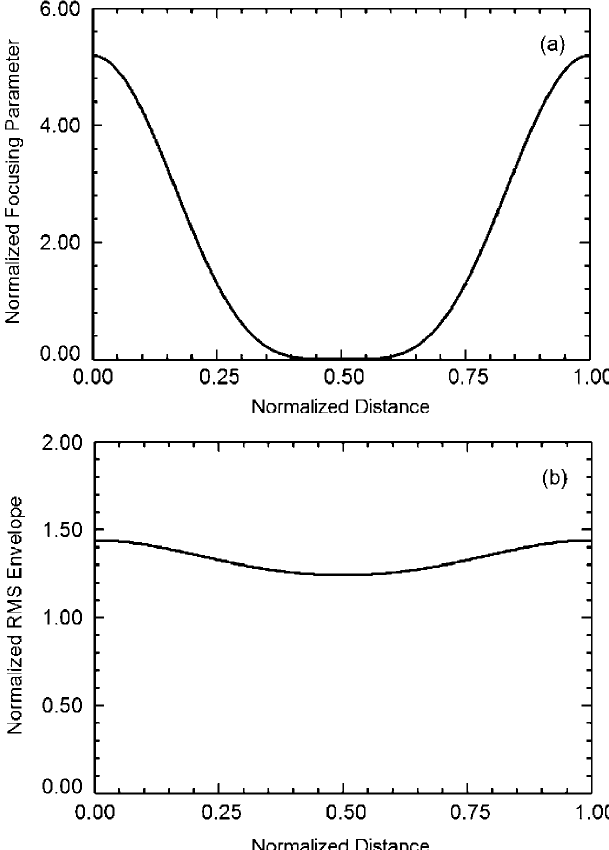
FIG. 1. Plots of (a) normalized focusing parameter S 2 (cid:7) z ð s Þ and (b) normalized rms envelope r b rms = ized distance s=S for the choice of system parameters corresponding to SK= 4 " th ¼ 7 : 0 , S